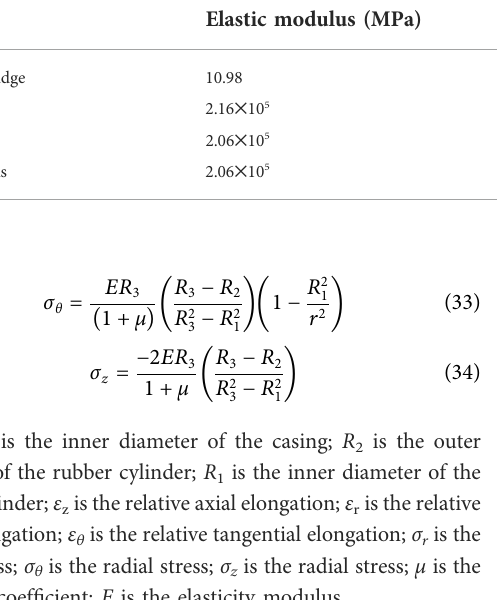
TABLE 5 Mechanical parameters of materials in key parts of